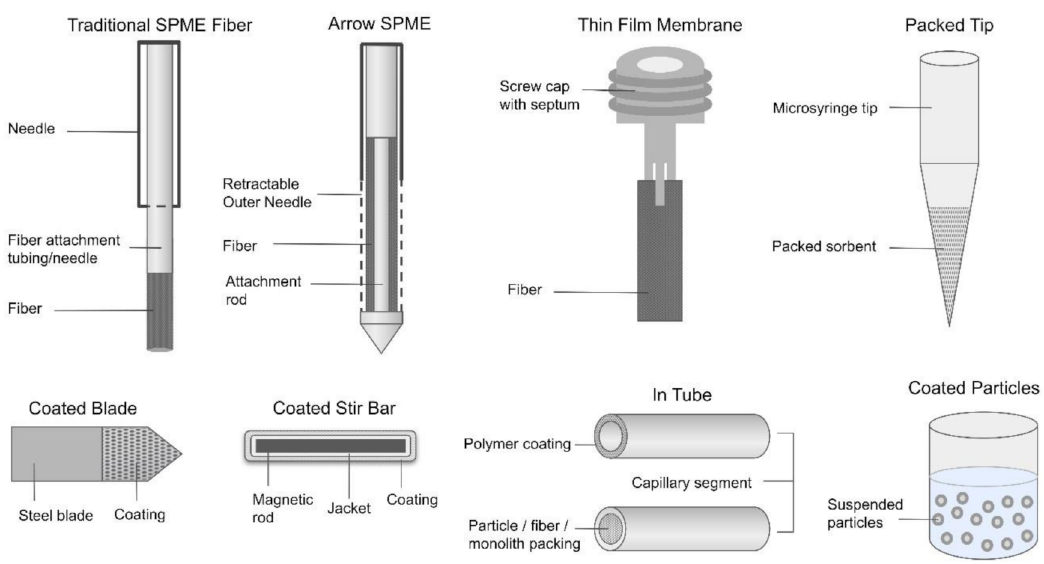
Figure 1. Solid-phase microextraction geometries. Figures not to